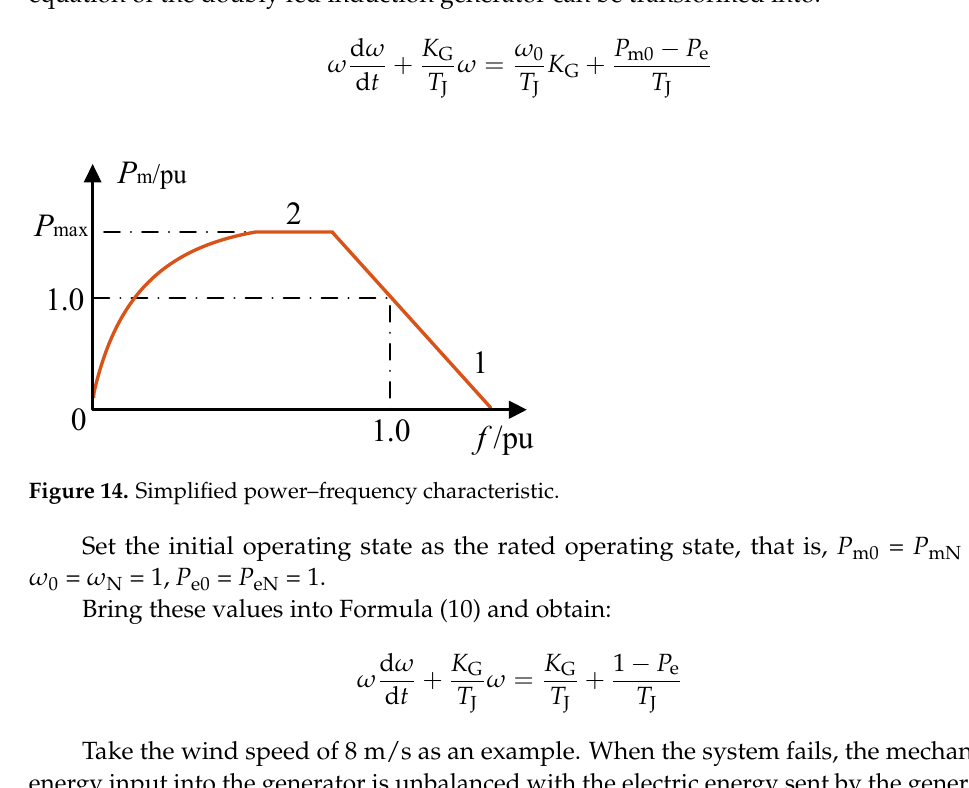
Figure 15. Transient speed ‐ change process of doubly fed induction generator with T J = 8 s, K G = 25, Δ P = 0.1,0.3,0.6.